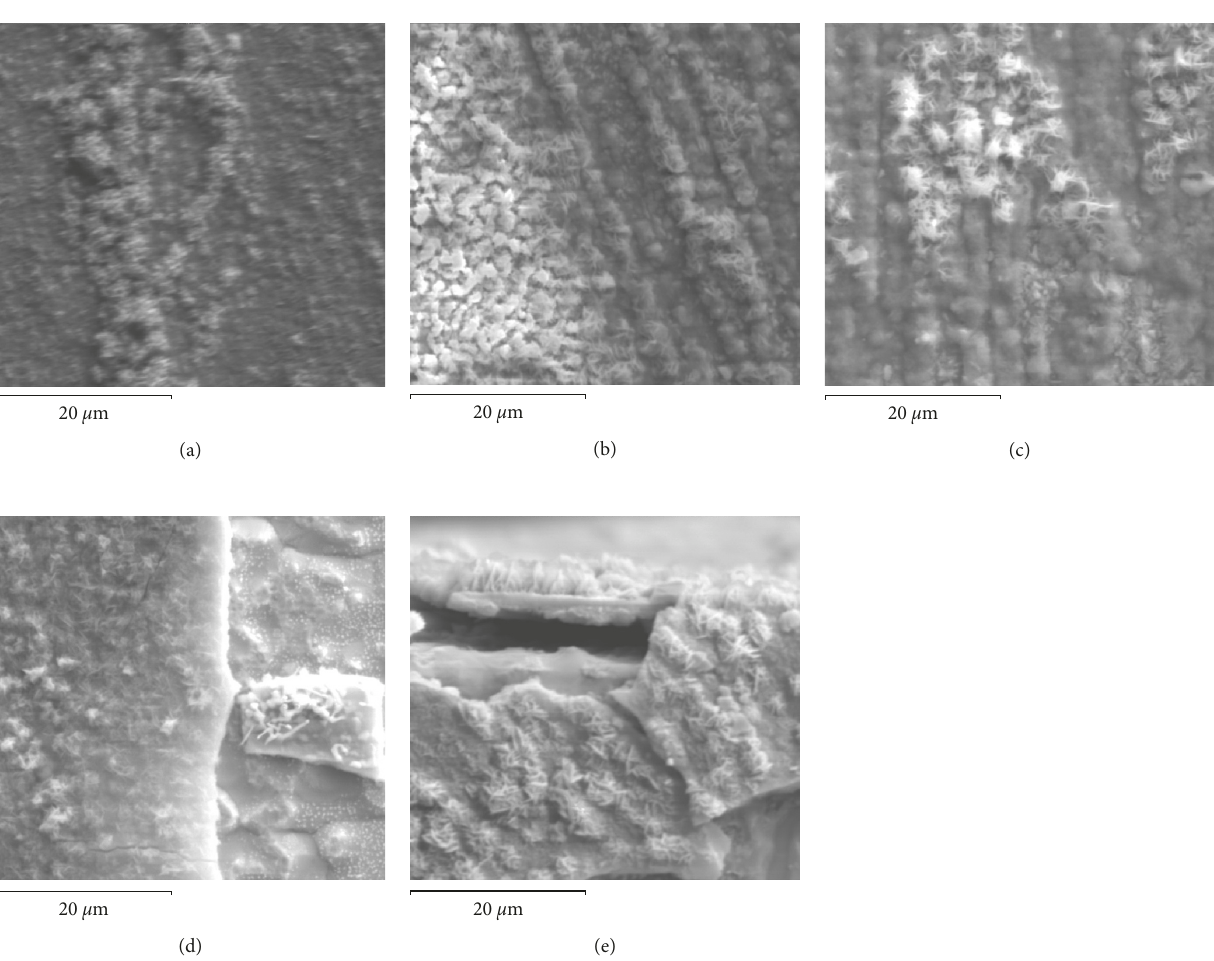
Figure 12: SEM micrographs showing the surface morphology of the oxide scales at 1000 ° C: (a) Ni Au, (d) Ni 3 Al +1.0% Pd, and (e) Ni 3 Al+1.0%